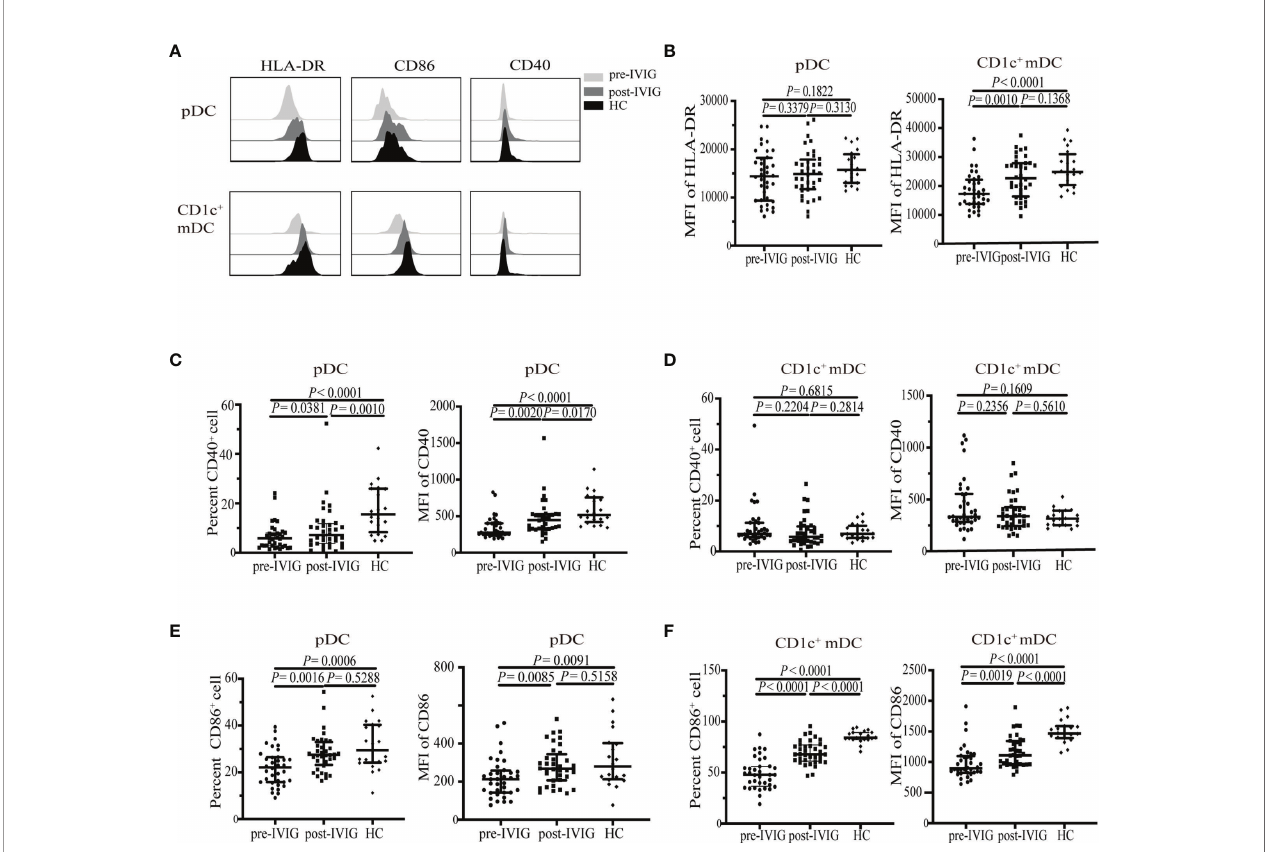
FIGURE 2 | Expression of HLA-DR, CD86 and CD40 on circulating DC subsets from healthy control (HC) (n = 20) and KD patients pre-and post-IVIG treatment (n = 36). (A) Representative histograms of HLA-DR, CD86, CD40 in DC subsets from a healthy control and KD patients pre-and post-IVIG treatment. (B) HLA-DR MFI on pDCs and CD1c + mDCs in KD patients and HCs. (C, D) Percentage and MFI of CD40 + on pDCs and CD1c + mDCs in patients with KD and HCs. (E, F) Percentage and MFI of CD86 + on pDCs and CD1c + mDCs in patients with KD and HCs. Horizontal bars represent median values, and error bars represent the interquartile range. MFI, mean fl uorescent